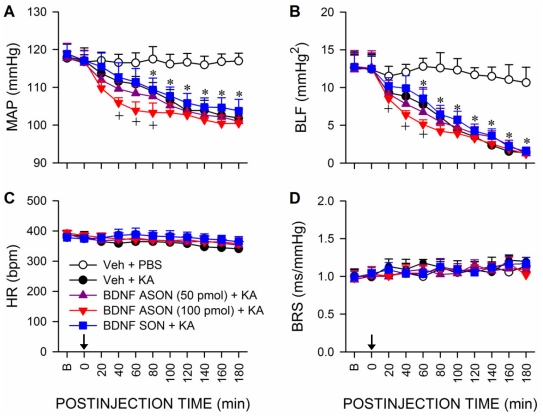
Upregulation of BDNF in RVLM ameliorates the reduced baroreflex-mediated sympathetic vasomotor tone during experimental TLSE.Temporal changes in MAP (A), power density of the BLF component (B), HR (C) or BRS (D) after microinjection of KA (0.5 nmol) or PBS into the left hippocampal CA3 subfield (at arrow) of animals that received pretreatment by application into the bilateral RVLM of distilled water (Veh), an antisense (ASON; 50 or 100 pmol) or sense oligonucleotide (SON) against bdnf gene (100 pmol). Values are mean ± SEM from 5–7 animals per experimental group.*P<0.05 versus Veh+PBS group, and +
P<0.05 versus Veh+KA group at corresponding time-points in the post hoc Scheffé multiple-range test. B = preinjection baseline.